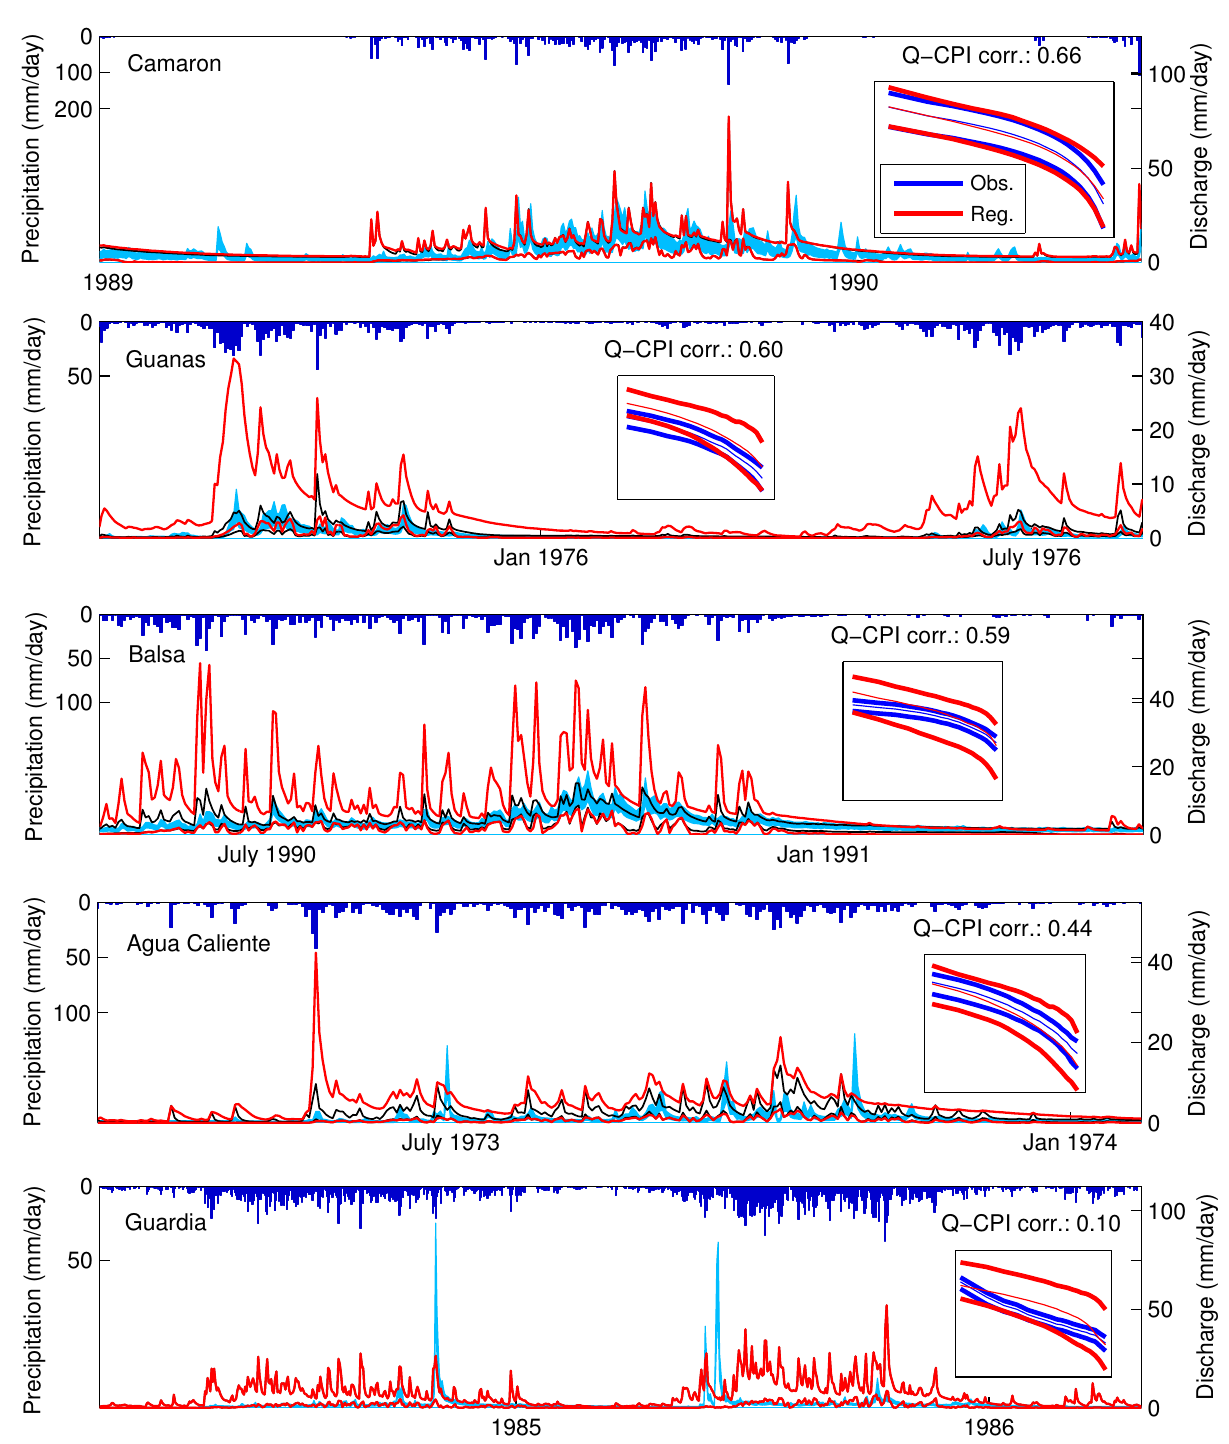
Figure 13. Precipitation (dark blue), comparison of simulated uncertainty bounds from regionalisation (red) and local calibration (black) with observed discharge (light blue) at Camaron (no. 22 with one of the best FDC regionalisation results), Guanas (no. 14 that, except for Guatuso, had the poorest FDC regionalisation when there were behavioural local simulations), Balsa (no. 6 with high FDC regionalisation uncertainty), Agua Caliente (no. 12 with a good FDC regionalisation but poorer data consistency and local calibration), and Guardia (no. 2 with inconsistent data and no local behavioural simulations). The regionalised (red) and observed uncertain (blue) FDCs are shown in log-log space (right in each plot) together with the correlation between discharge and CPI for intermediate and high flows. The observed FDCs are plotted as used in the local calibration, i.e. without added temporal